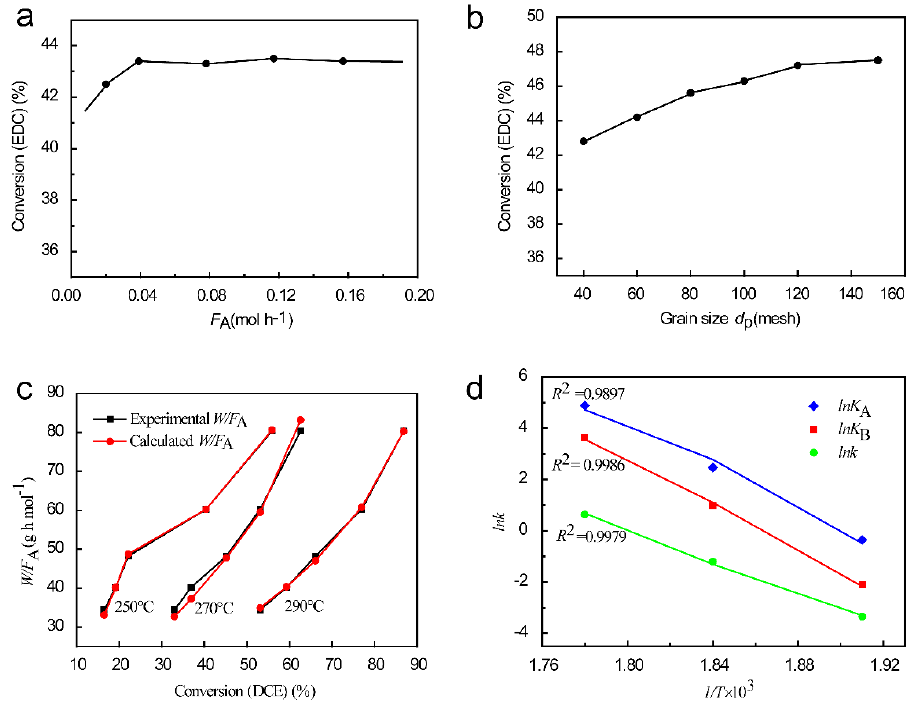
Figure 5. ( a ) Elimination of external diffusion. ( b ) Elimination of internal diffusion. ( c ) Comparison of calculated W / F A and experimental W/F A values. ( d ) Correlations between ln k , ln K A , ln K B and 1/ T . Reaction conditions: 260 °C, LHSV 0.5 h − 1 , 1 atm.